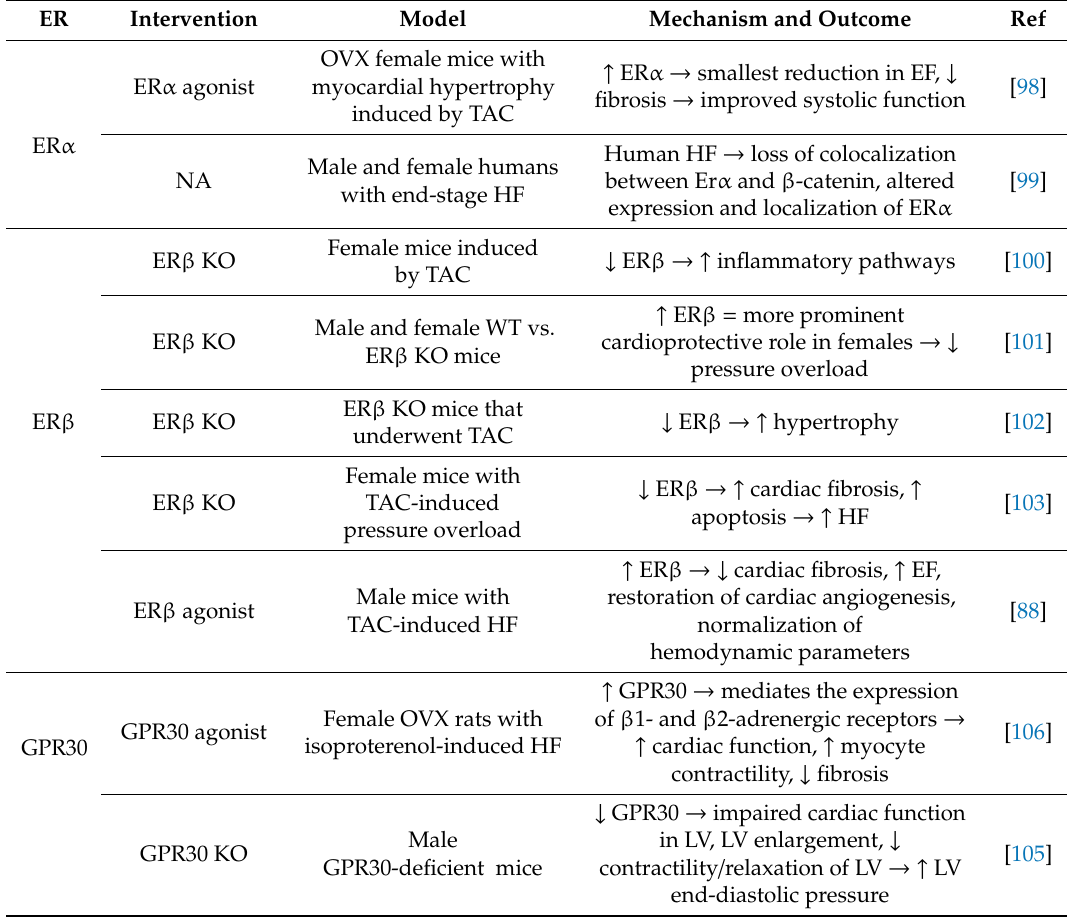
Table 5. Role of estrogen receptors in heart failure with reduced ejection